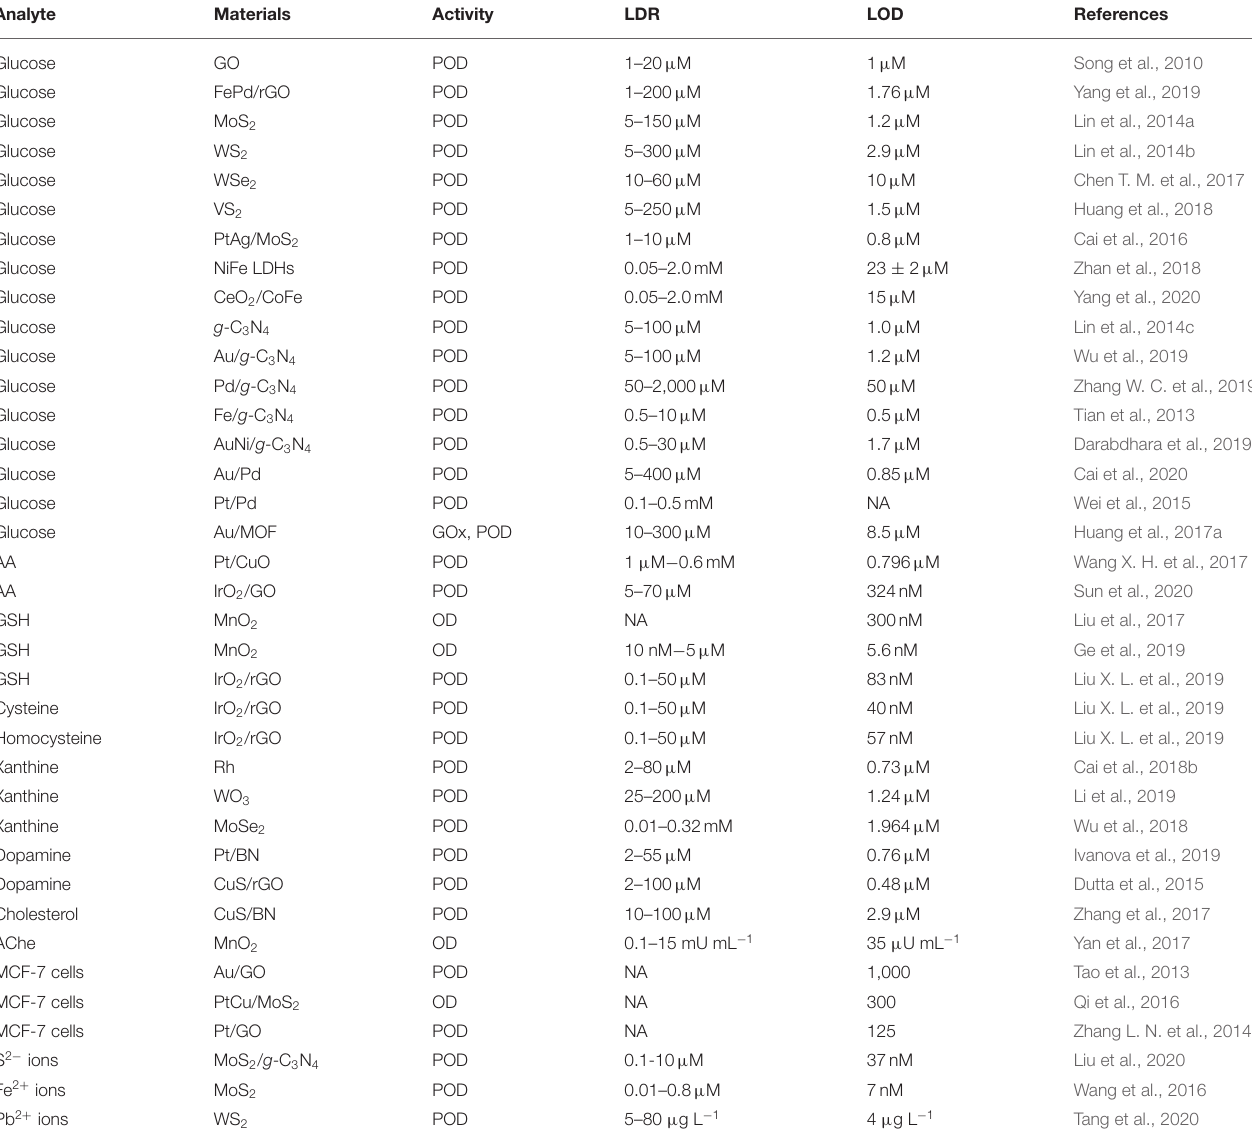
TABLE 2 | Summary of several typical 2D nanozymes for colorimetric detection of various target analytes.